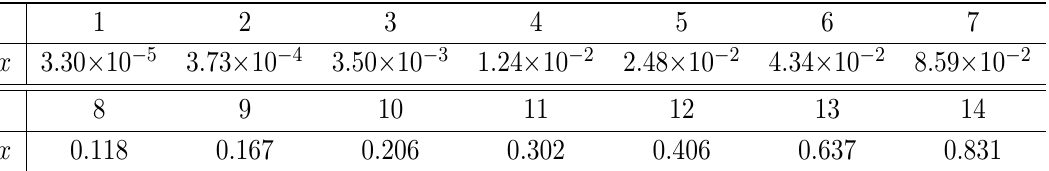
Table 4 . The x values we choose for the training and test samples of